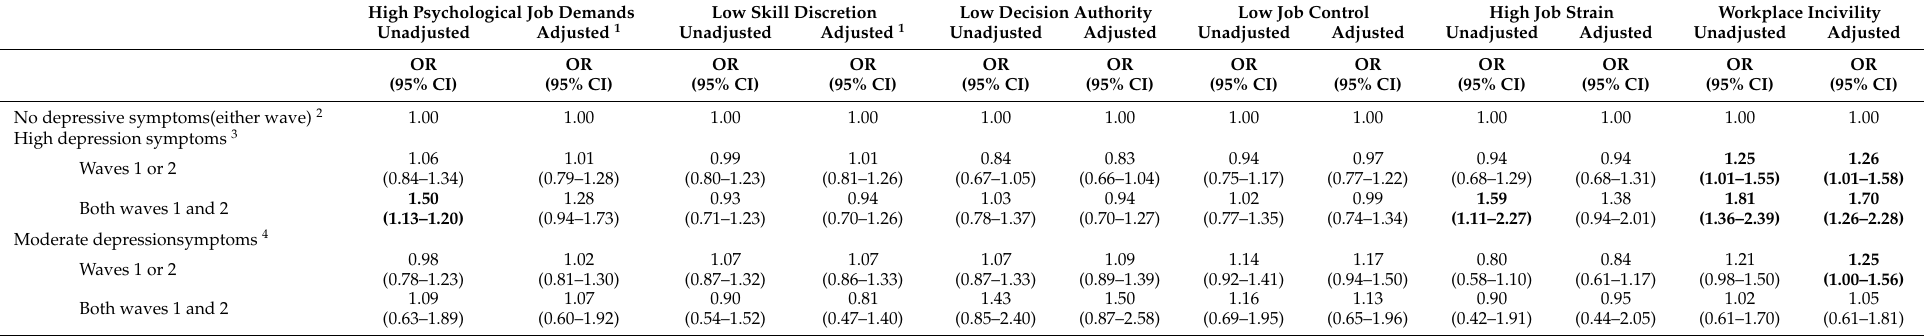
Table 3. Prospective associations between symptoms of depression, and subsequent exposure to perceived psychosocial job domains in those currently employed at wave three ( n =